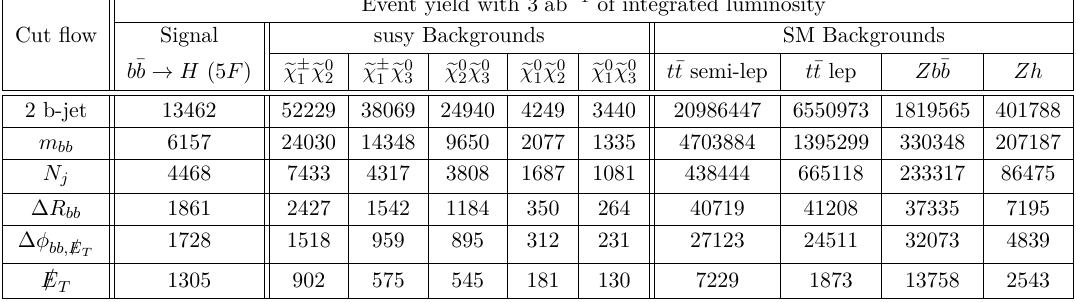
mode with 5F signal T